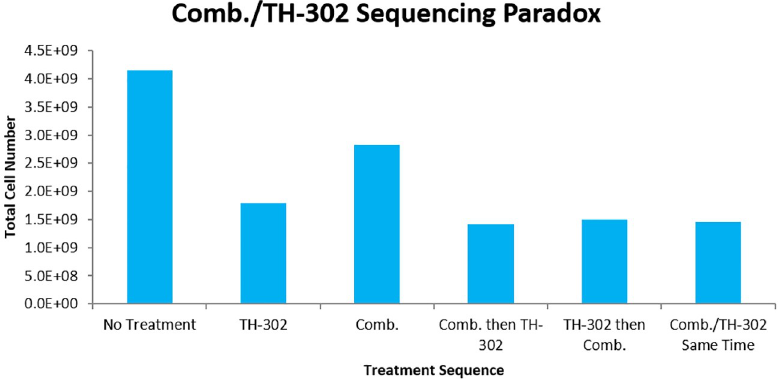
Fig 7. Combretastatin/TH-302 sequencing paradox with vessel normalization. The tumour is allowed to grow for 18 days before the start of treatment. Five doses of drugs are given in 2 day increments, each at the same strength. If both types of drugs are given non-simultaneously, then there is a 6 hour delay between their administrations. The optimal schedule is to give combretastatin 6 hours prior to TH-302, although it is only slightly better than other sequences. Furthermore, the combination therapy fails to show any drug synergy